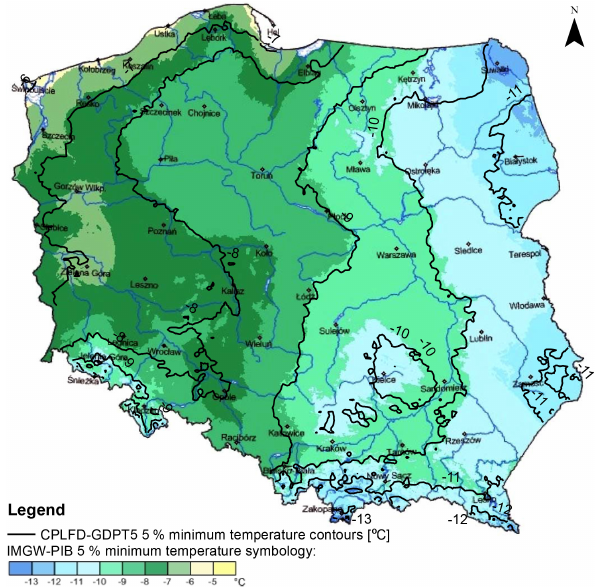
Figure 14. Comparison of CPLFD-GDPT5 95% maximum- temperature contours with IMGW-PIB 95% maximum-temperature map for the 1971–2000 period. Contours are in 1 ◦ C intervals. The IMGW-PIB map indicates also major rivers (blue lines) and major cities (labelled black circles). The IMGW-PIB map is adapted from the Climatic Maps of Poland (IMGW-PIB,